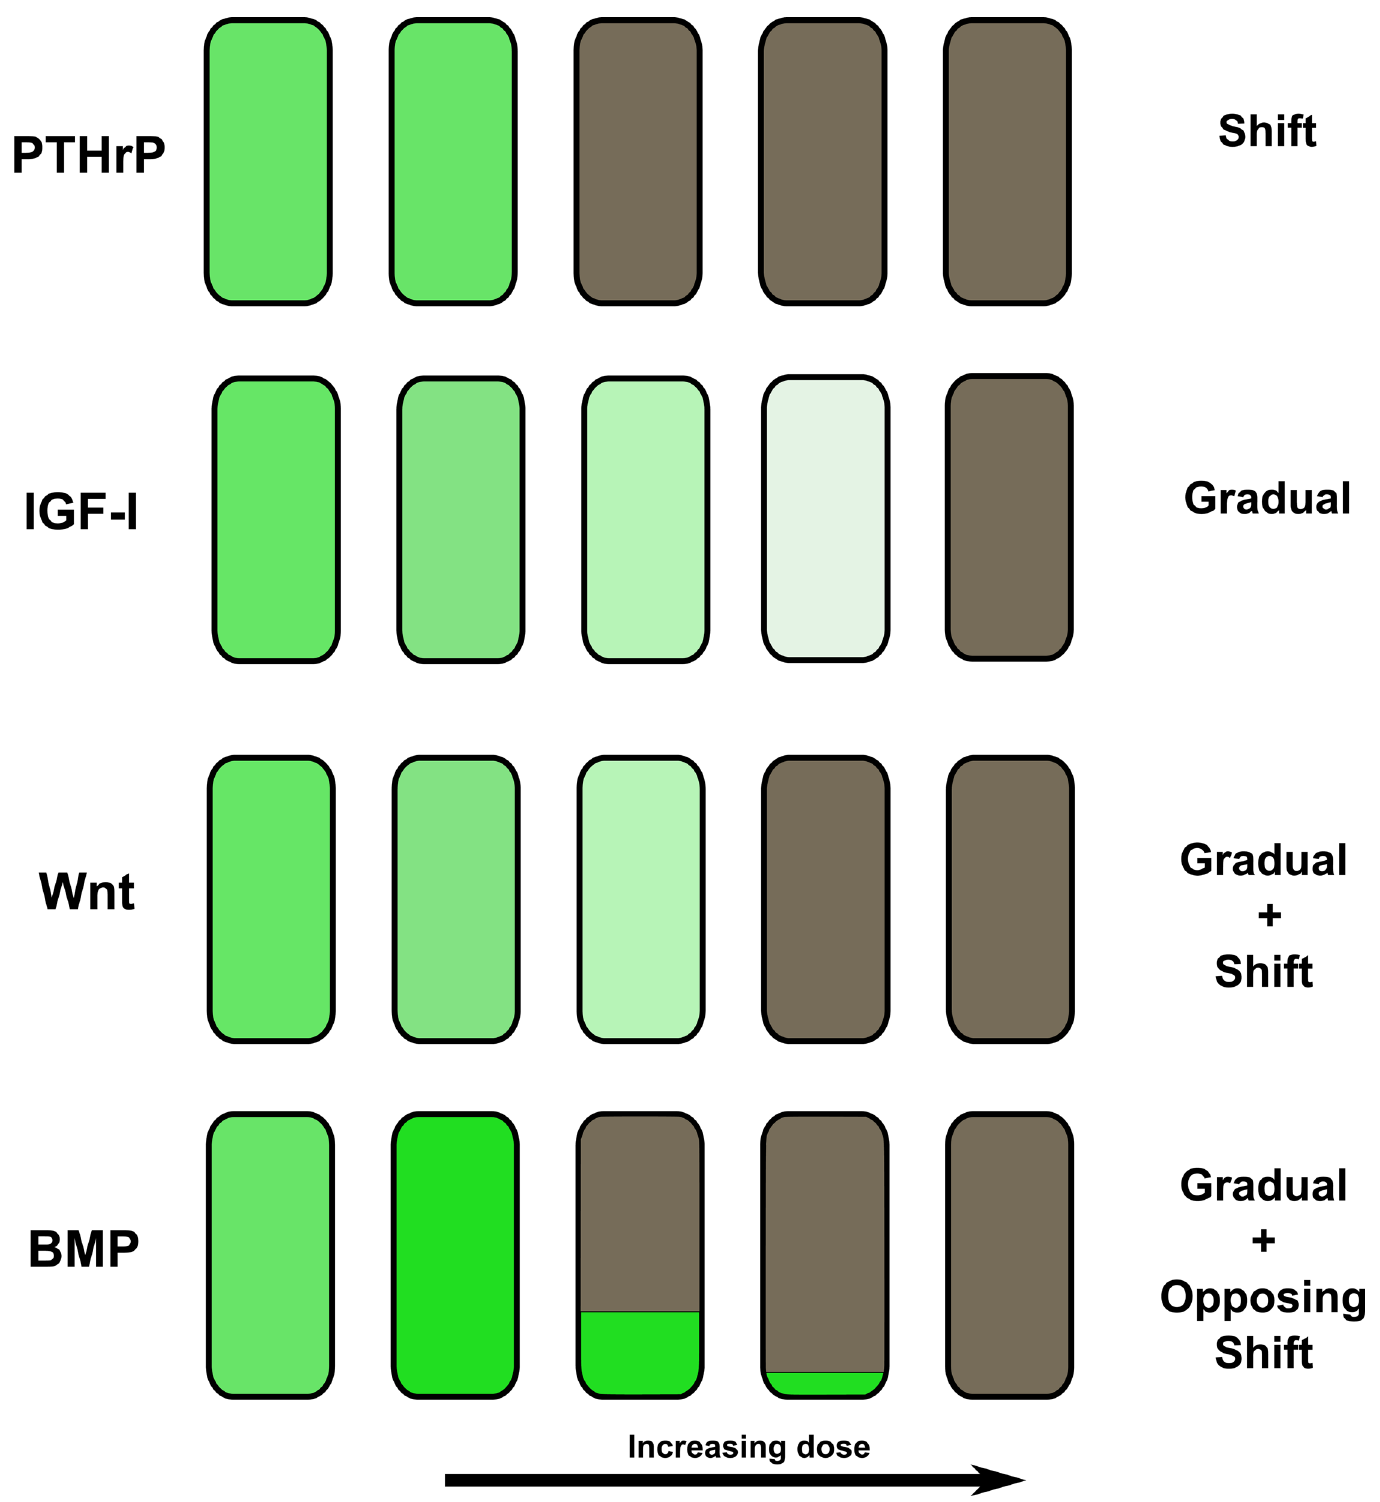
Fig 5. Qualitatively different outcomes of increasing activity. The dose response of the network to an increase in the activity of a growth factor can show different outcomes depending on the growth factor. Attractors are colour-coded with green standing for attractors with Sox9 activity and grey for other attractors. The tint gives an indication of Sox9 activity. Dark green indicates high activity, light green indicates low activity. The response can be almost